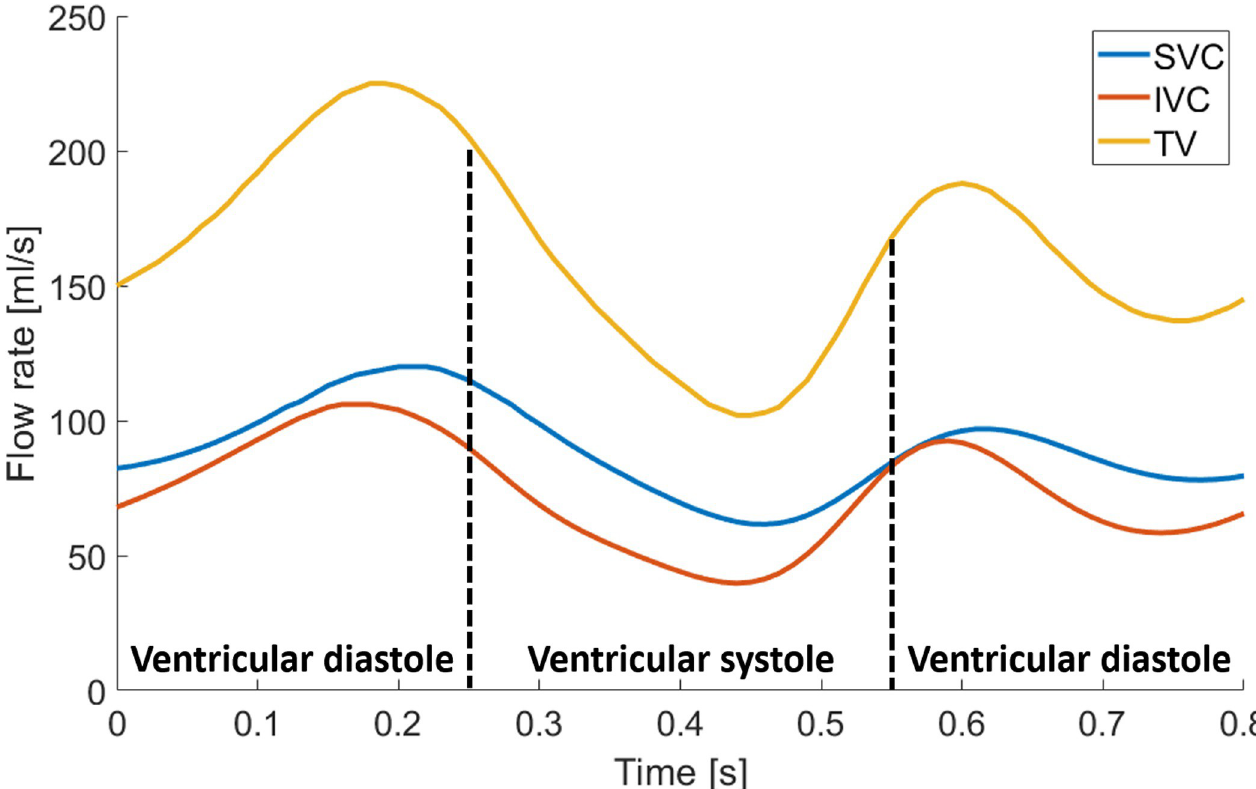
Fig 11. Blood flow rate profiles over one cardiac cycle at SVC, IVC and TV boundaries (generated with data from the S10 File).